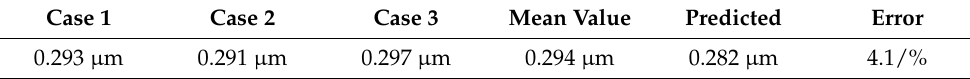
Table 9. Validation of experimental results.